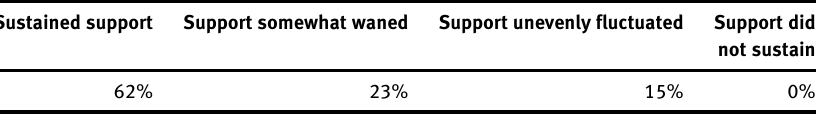
Table  : Sustainability (n = 